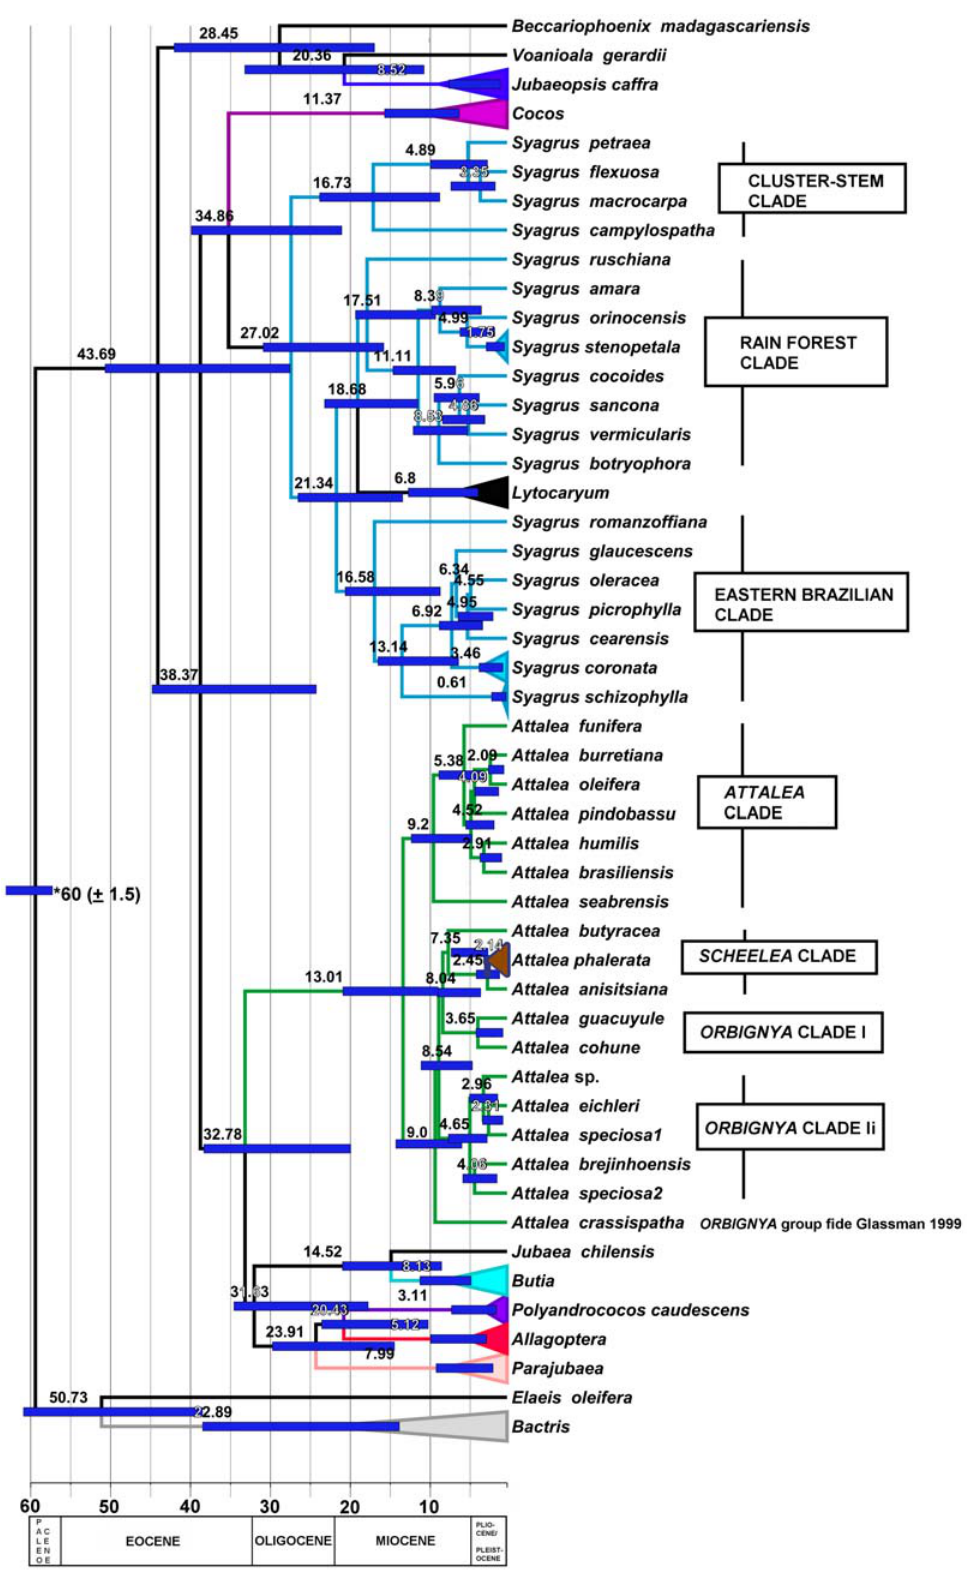
Figure 3. Maximum clade credibility chronogram generated from 21,000 trees samples by non-partitioned Bayesian analysis of seven combined WRKY loci sequences aligned across Areceaceae tribe Cocoseae subtribe Attaleinae with BEAST, drawn with branches proportional to absolute age in millions of years. Numbers are mean node ages; blue bars at nodes represent range of 95% HPD for the age estimate. Triangles indicate collapsed generic, sub-generic or species nodes. *=calibration point.